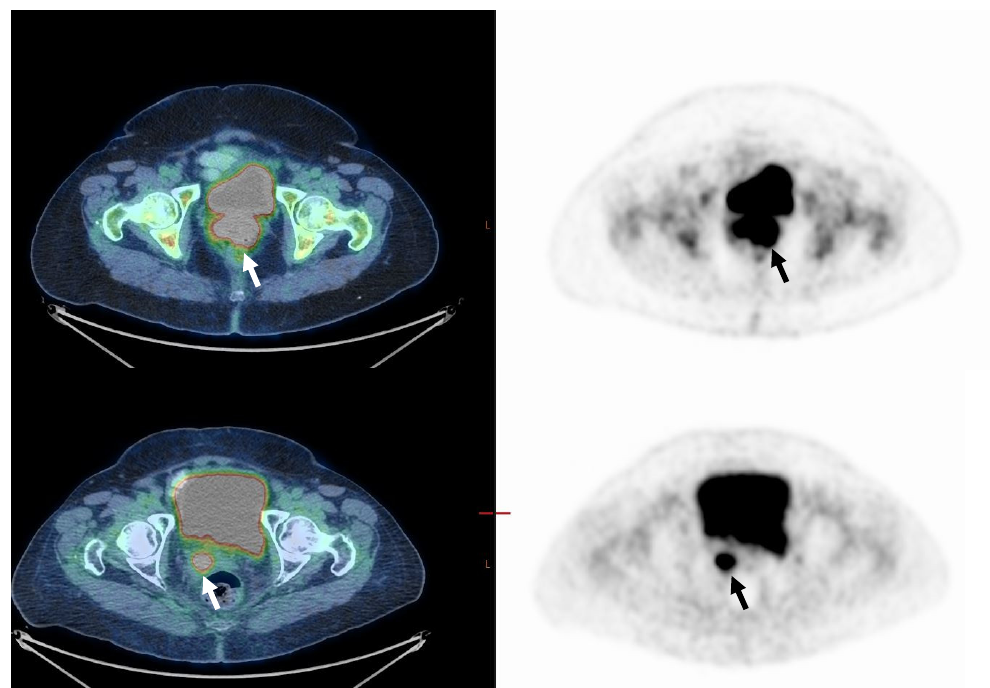
Figure 2. Seventy-year-old woman with FIGO stage IIB disease cervical cancer (Squamous cell carcinoma). On staging, PET/CT images (upper row) demonstrate pathological uptake in the primary tumor only (arrow). MTV was 85.0 cm 3 , and TLG 1411.2. On PET/CT performed about 3 months after the end of treatment (lower row), there is still pathological FDG uptake in the primary tumor (n-CMR, arrow). In addition, a new pathological lymph node has appeared in the right pelvis (not shown in this figure), indicating disease progression.